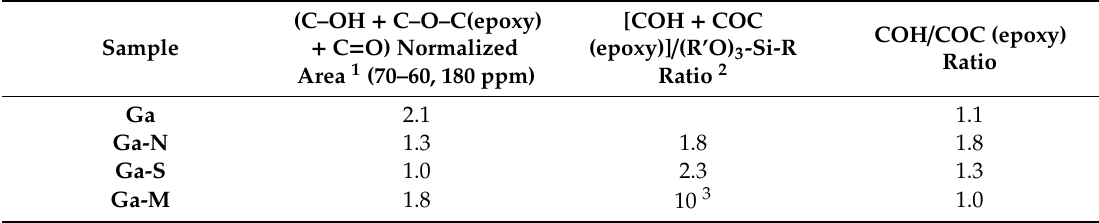
Table 2. Comparison of the number of oxidized C sites, extent of functionalization, and preferential anchoring sites in the di ff erent samples. Data were obtained through the profile fitting analysis of the 13 C MAS